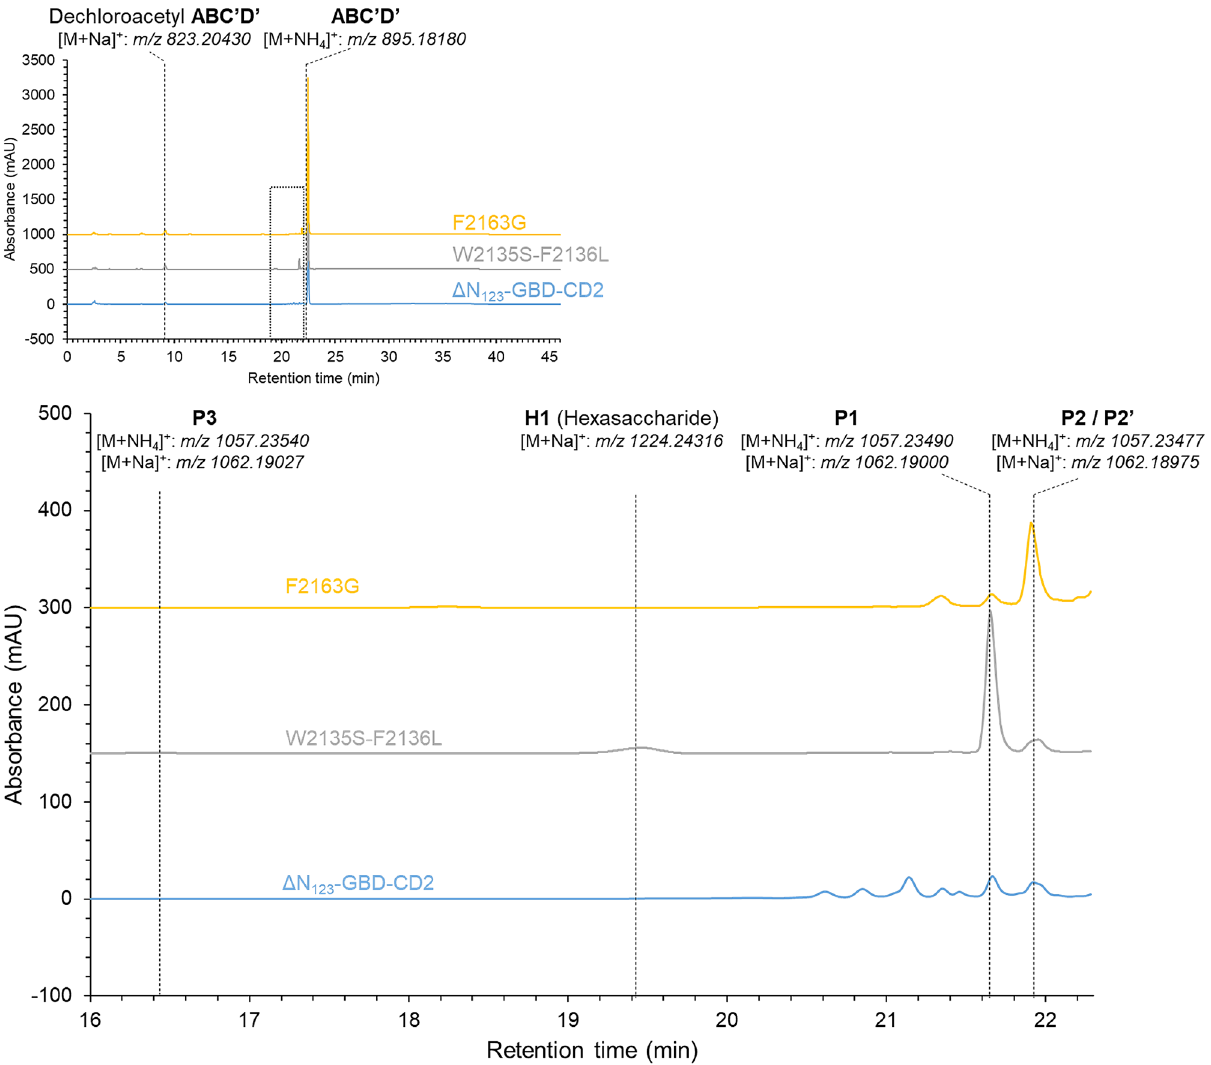
Figure 2. HPLC-UV 220nm and HRMS analysis of glucosylation products obtained with ΔN 123 -GBD-CD2 branching sucrase and its mutants, W2135S-F2136L and F2163G after 16 h of reaction in the presence of sucrose (1 M) and tetrasaccharide ABC ′ D ′ (50 mM) at pH 5.1 using 1 U mL −1 enzyme and 30 °C. A zoom of the product region located between 16 and 22.3 min is shown. P1 ( t r = 21.65 min), P2/P2 ′ ( t r = 21.9 min), P3 ( t r = 16.4 min) and H1 ( t r = 19.45 min). A shift in molecular mass by 162 Da, characteristic of monoglucosylation, was observed for P1 , P2/P2 ′ and P3 and a shift of 362 Da (di-glucosylation) was observed for H1 ( m/z detected by HRMS indicated below each product and corresponding to NH4 + or Na + adducts in positive